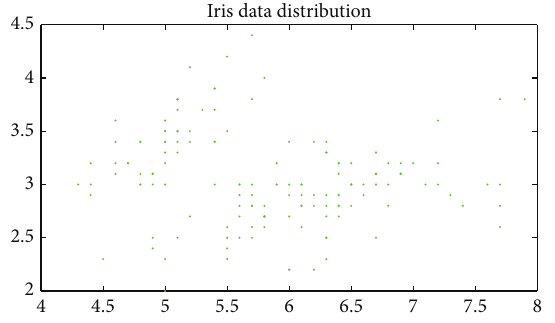
Figure 18: The Iris data